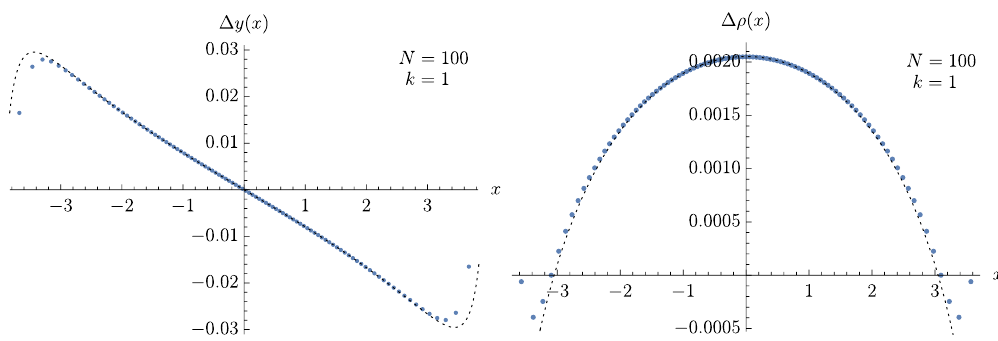
Figure 2 . The numerical solution for y ( x ) and (cid:26) ( x ) with the leading order behavior subtracted out. The dotted lines correspond to the subleading solution, (4.23), with the unknown constants determined numerically. Here we have taken N = 100 and k = 1.